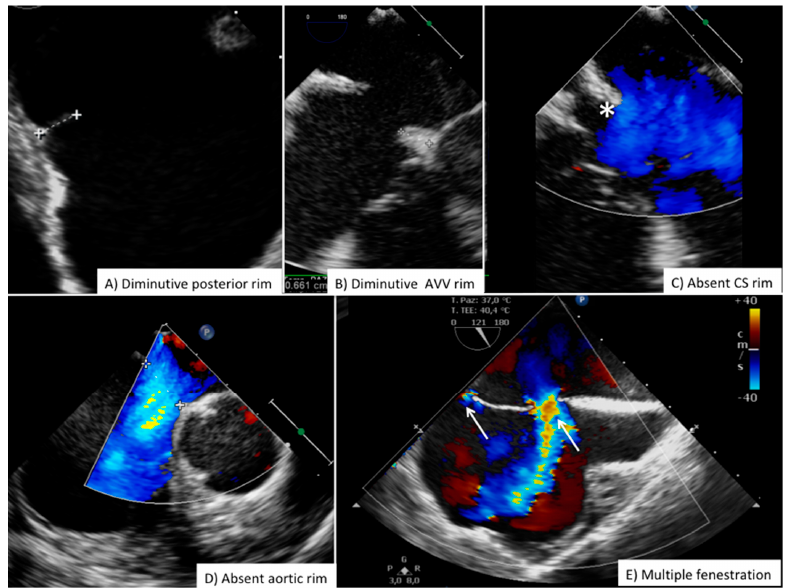
Figure 7. Challenging anatomies for ASD closure. Common anatomical features increasing procedural complexity and complication rate during ASD closure. ASD = secundum type Atrial Septal Defect; AVV = Atrio-Ventricular Valve; CS = Coronary Sinus.